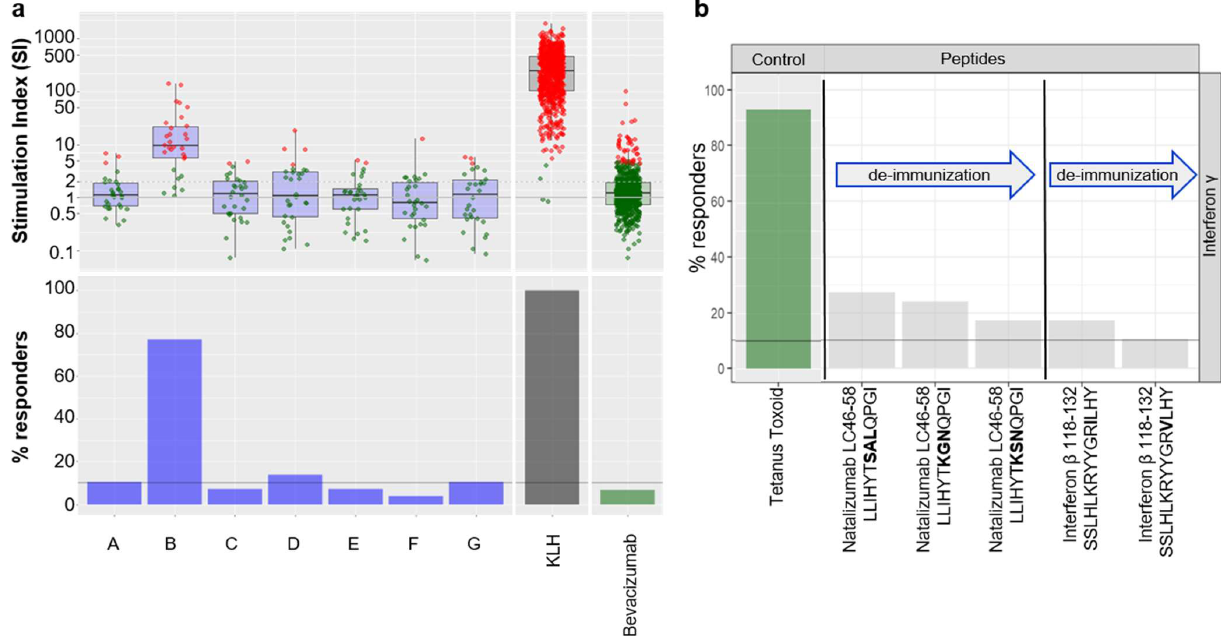
Figure 4. Case studies in pre-clinical research. ( a ) Stimulation Index (SI) obtained for 7 different candidate compounds of the same project (named A to G). The change in color, from green to red, depicts the positivity of the donor within the screen. The lower panel represents the proportion of positive donors. The threshold derived from the validation study is set at 10% positive donors. ( b ) DC:CD4+ re-stimulation results obtained for a selection of known T cell epitopes derived from biotherapeutics and their “de-immunized” counterparts.